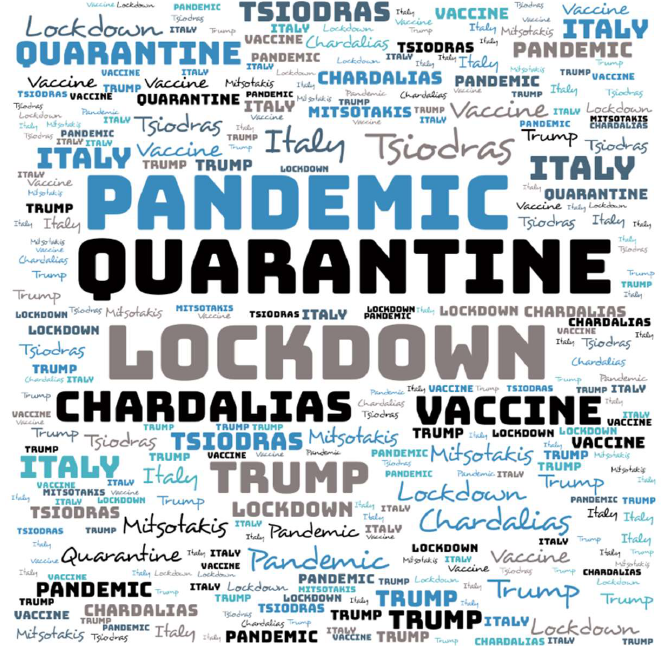
Table 4. Top 10 most frequently used words in tweets.